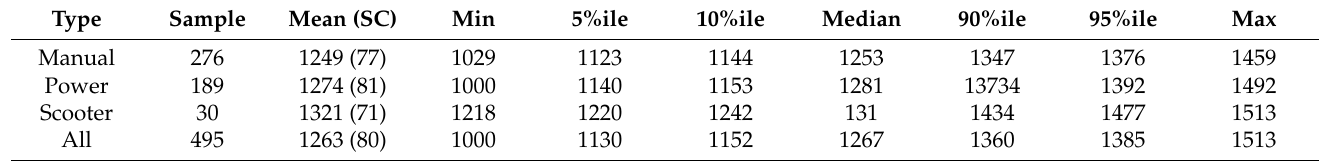
Table 3. Occupied height for different types of wheeled mobility devices (adapted from